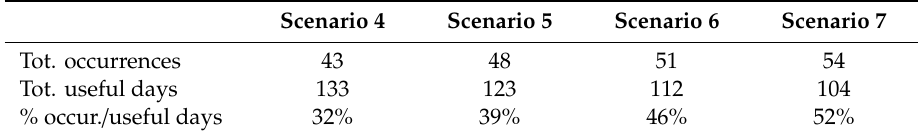
Table 5. Scenarios 4–7 are the only scenarios that take into consideration the presence of the value of equilibrium. Scenario 4 Scenario 5 Scenario 6 Scenario 7 Tot.